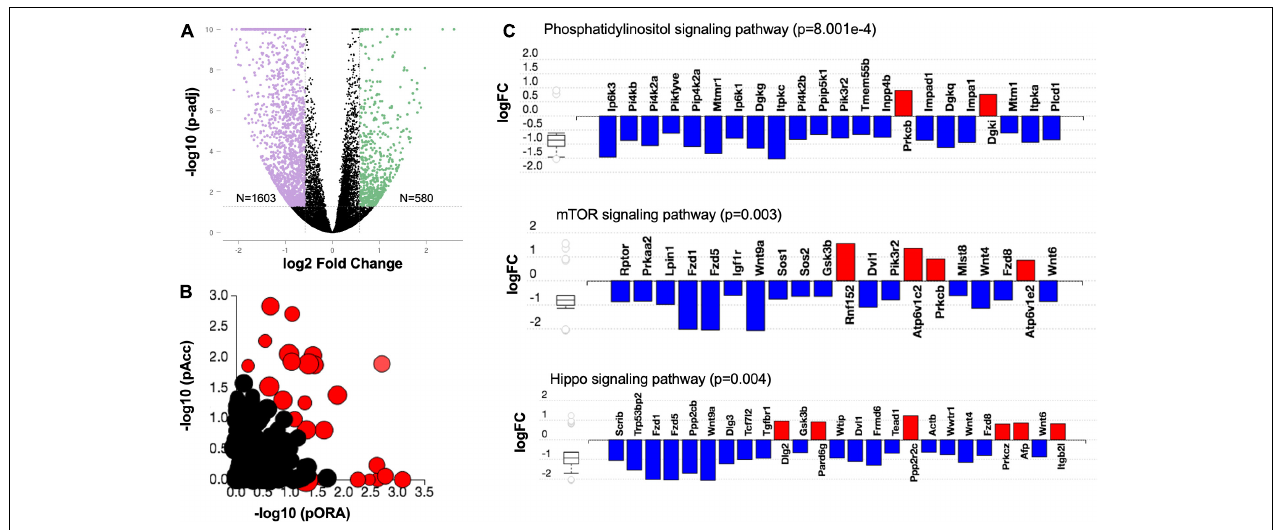
FIGURE 7 | Downregulation of cellular growth pathways in the oocyte is associated with meiotic competence. (A) Volcano plot for differentially expressed genes (fold change + 1.5 and − 1.5 and adjusted p < 0.05) between meiotically competent (PND 16 large and PND 40) and non-competent (PND 13 and PND 16 small) oocytes. (B) Evidence plot for significantly enriched pathways. Red bubbles represent significant pathways ( p -value correction factor), and black bubbles represent non-significant pathways. The size of each bubble corresponds to the number of genes affected in that pathway. The horizontal axis shows the inverse log of p -value computed using over representation analysis (pORA). The vertical axis shows the inverse log of p -value for the accumulated perturbation of the pathway (pAcc). This approach is called the impact analysis and combines the p -value into the global p -value which is displayed in Table 1 . (C) Differentially expressed genes in Phosphatidylinositol ( p = 8.001e–4), mTOR ( p = 0.003) and Hippo signaling ( p = 0.004) pathways in meiotically competent as compared to sub-competent